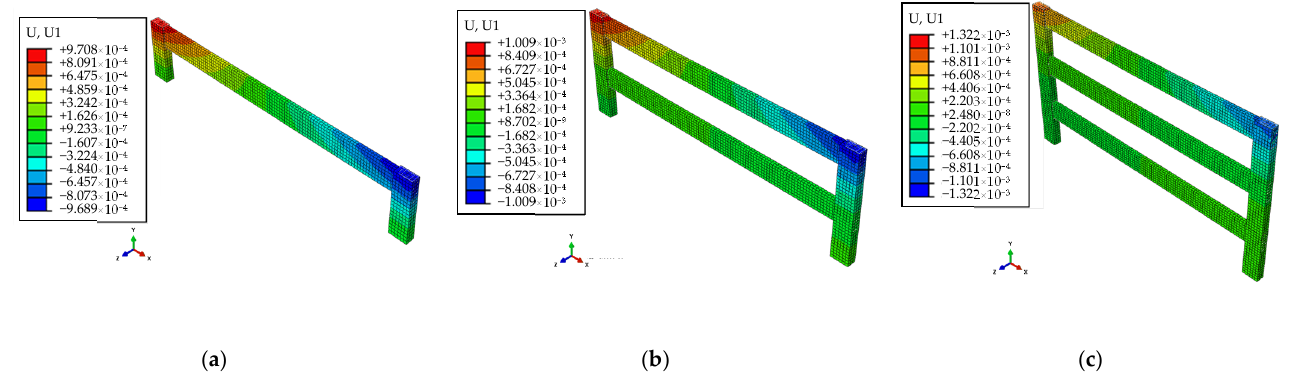
Figure 12. The X-direction displacement of the layer-by-layer stretching plan. ( a ) Stretching of first layer prestressed tendons. ( b ) Stretching of second layer prestressed tendons. ( c ) Stretching of third layer prestressed tendons.